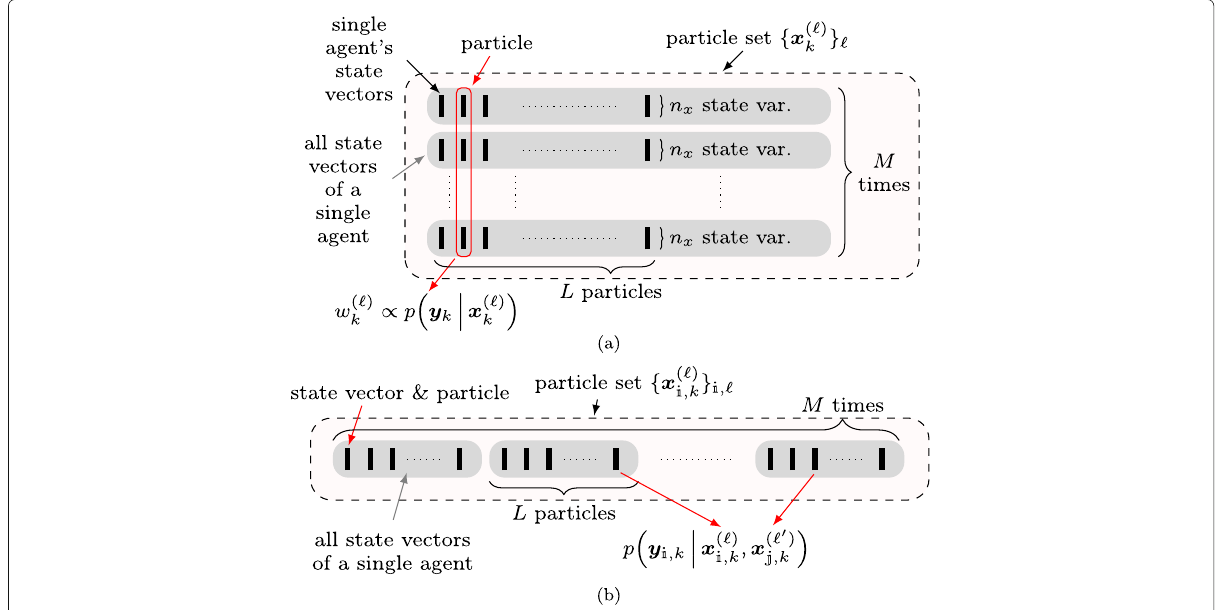
Fig. 1 Illustrations of a classical and b MPF particle representations, where n x denotes the dimension of the state vectors